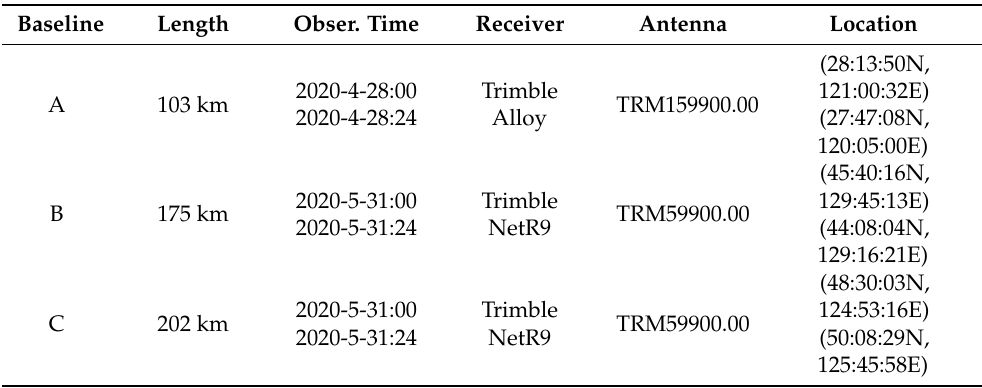
Table 3. Information of baselines employed in the experimental